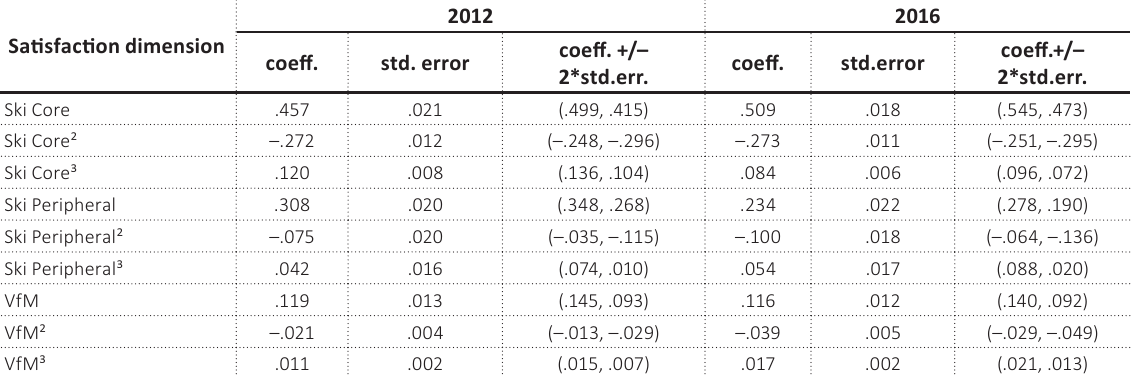
Table 2. Coefficients and 95% confidence intervals for the linear, quadratic, and cubic terms 2012–2016 Satisfaction